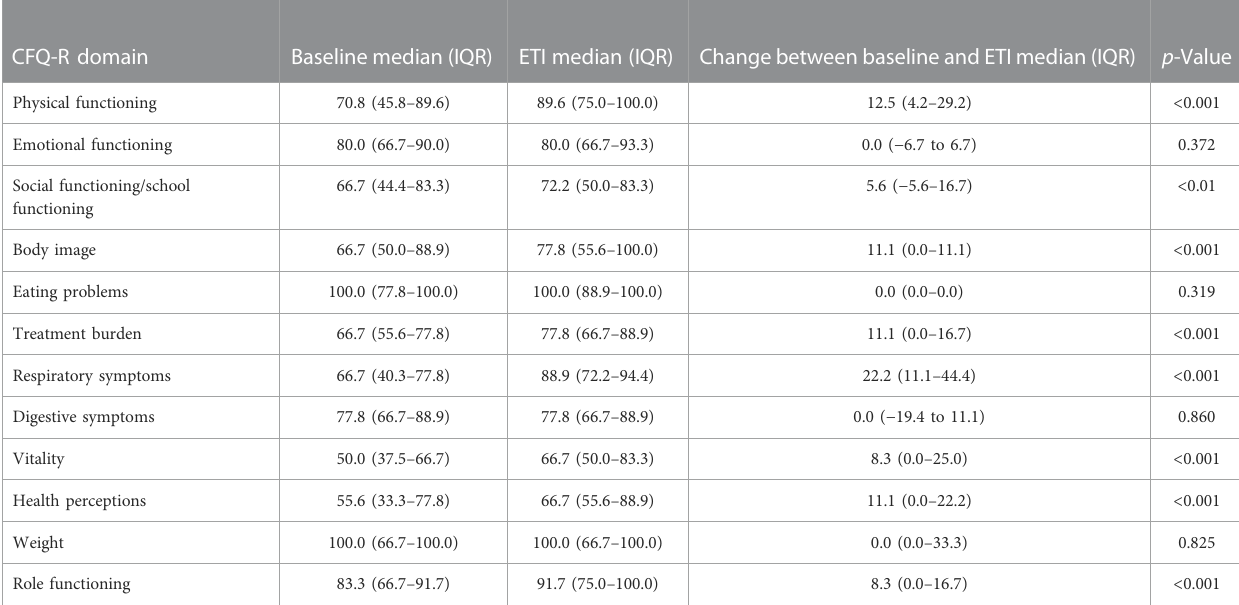
TABLE 2 Effects of elexacaftor/tezacaftor/ivacaftor (ETI) on quality of life determined by the Cystic Fibrosis Questionnaire-Revised (CFQ-R).